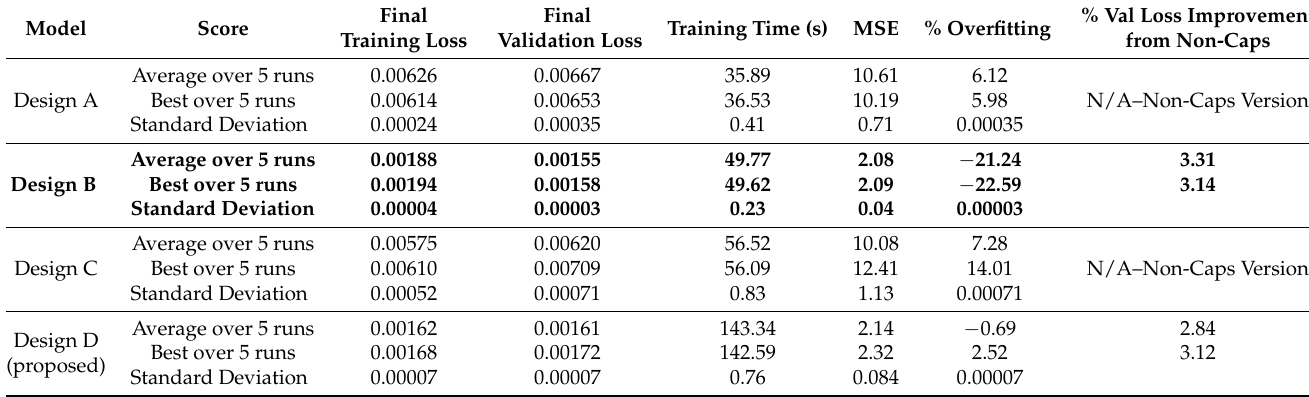
Table 7. Results for training for each NN model in Figure 5 using hyperparameters from Table 3.